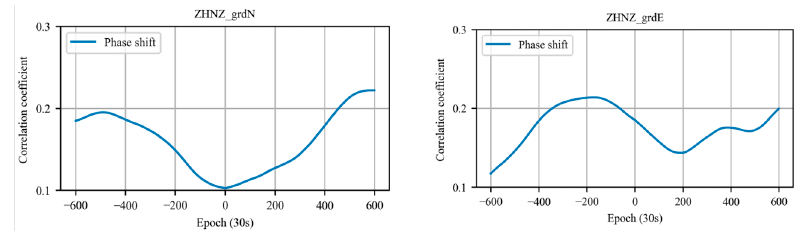
Figure 9. Correlation coefficients between horizontal north (left) and east gradient (right) with respect to the rainfall.